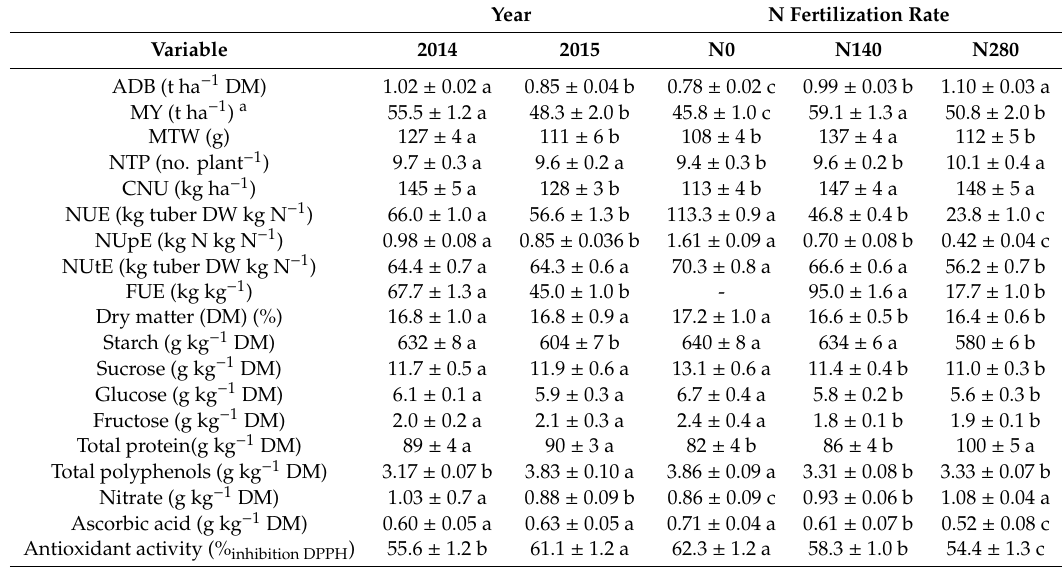
Table 4. Aboveground dry biomass, yield components, N e ffi ciency indices and tuber chemical characteristics of “early” potato as a ff ected by the main e ff ects. Di ff erent letters between years or among N fertilization rates within the same row show significant di ff erences (LSD test, p <